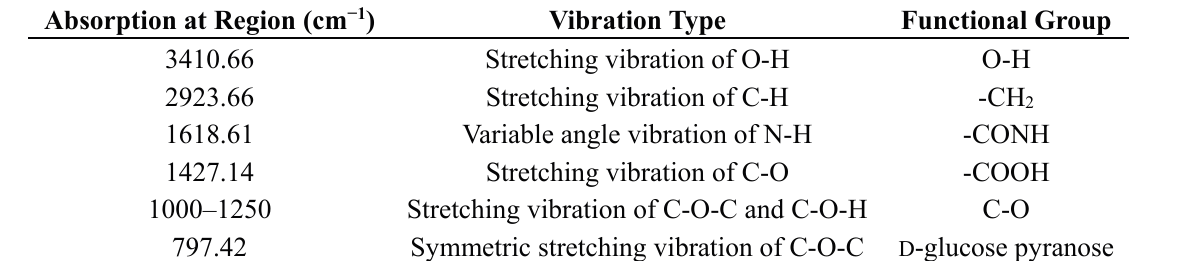
Table 1. Characteristic FT-IR peaks of AAP IV.